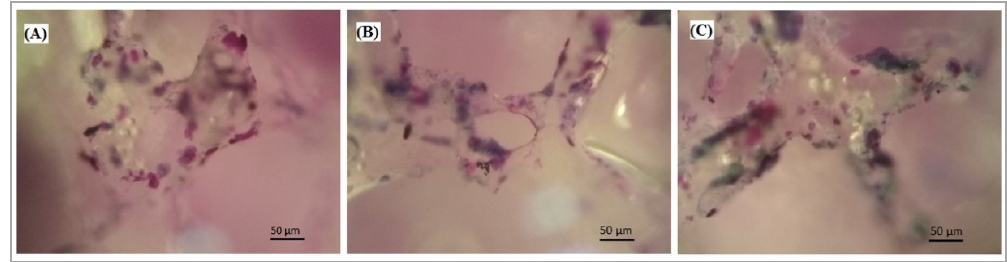
Figure 7. Formazan produced by MMSC seeded on PLA, PLA/HA 15%, and PLA/HA 20% scaffolds determined by MTT assay.